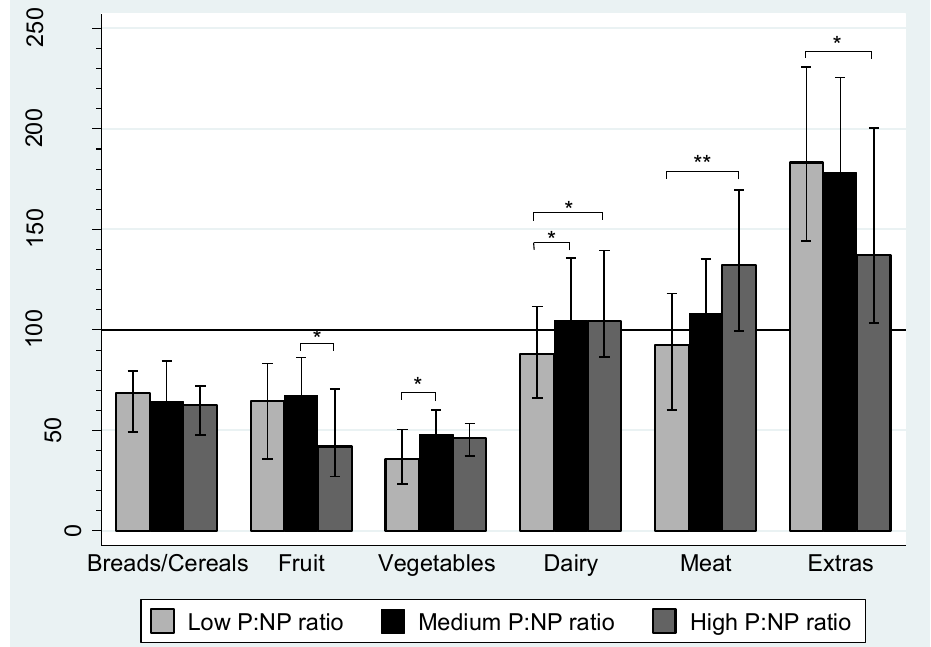
Response surfaces for the effects of maternal macronutrient intake during pregnancy on selected micronutrient intakes (folate, iron, vitamin E, calcium, magnesium and zinc) are presented in Figure 4. Folate and iron intakes were maximized with low protein (<16%E), intermediate fat (30%E) and high carbohydrate (>54%E) intakes. Intakes of all remaining micronutrients (including those not shown) were optimized with a maternal diet of intermediate protein (18%E–20%E), intermediate